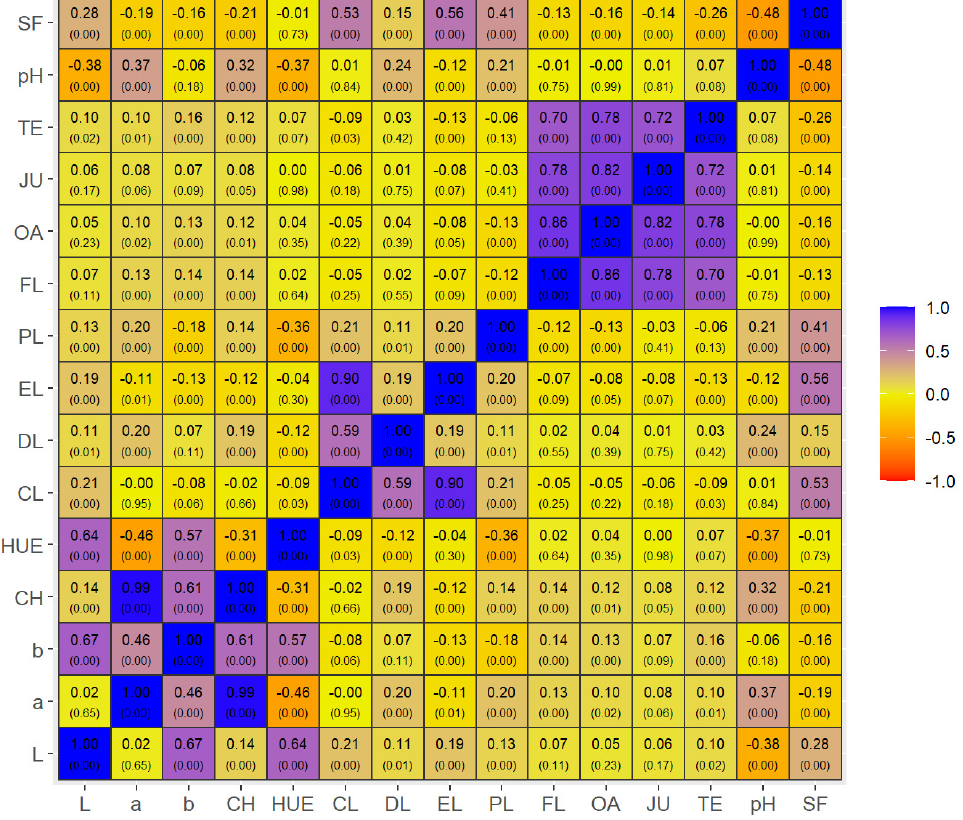
Figure 2. Pearson correlation (uppercase numbers) and significance (lowercase numbers; p -values) of Brangus heifers. Blue or purple colors means strong or medium positive correlations, while orange or yellow/browned colors means strong or medium negative correlations. Variables: SF = shear force; pH = ultimate pH (48 h post-mortem); TE = sensory tenderness; JU = juiciness; OA = overall acceptance; FL = liking of flavor; PL = purge loss; EL = evaporation loss; DL = drip loss; CL = total cooking losses; HUE = real color; CH = chromaticity; b * = yellowness; a * = redness; and L * = lightness.